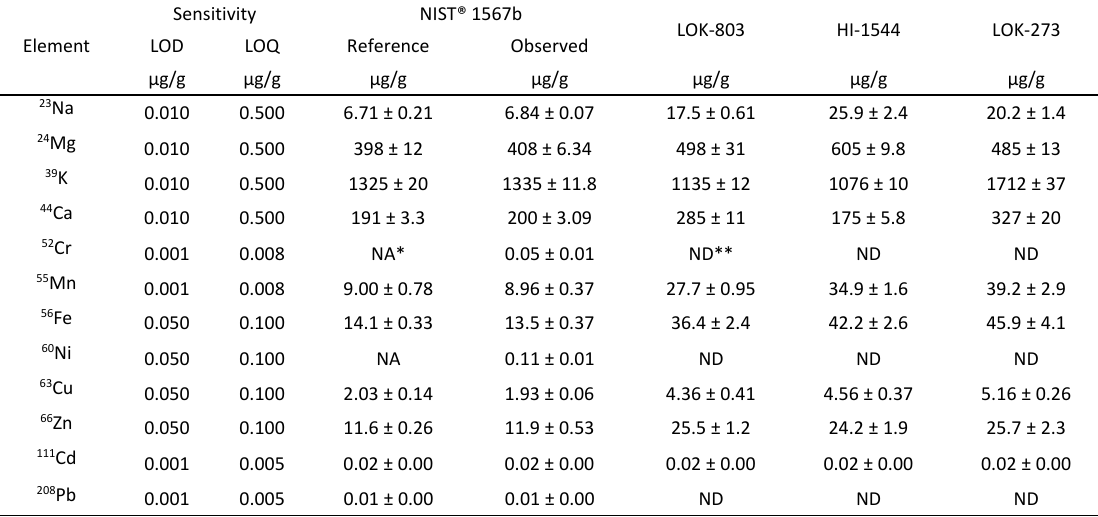
Table 3: Elemental analysis of NIST®1567b wheat flour and wheat varieties LOK‐803, HI‐1544, and LOK‐273 using ICP‐MS